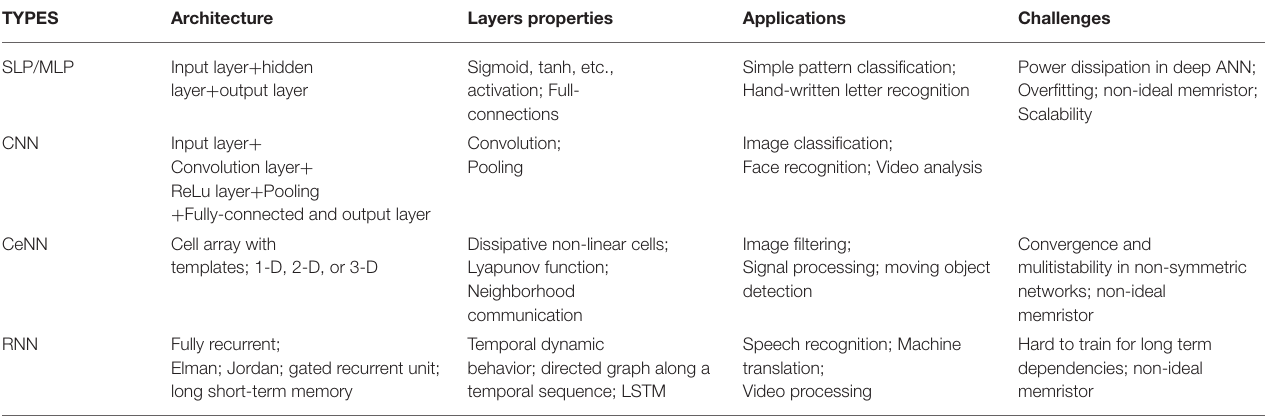
TABLE 3 | Typical architectures of Memristive ANNs.